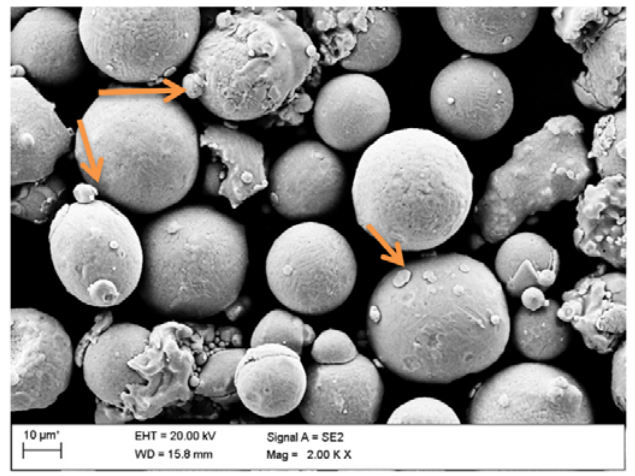
Figure 2. The microstructure of 18Ni ‐ 300 maraging steel powder.